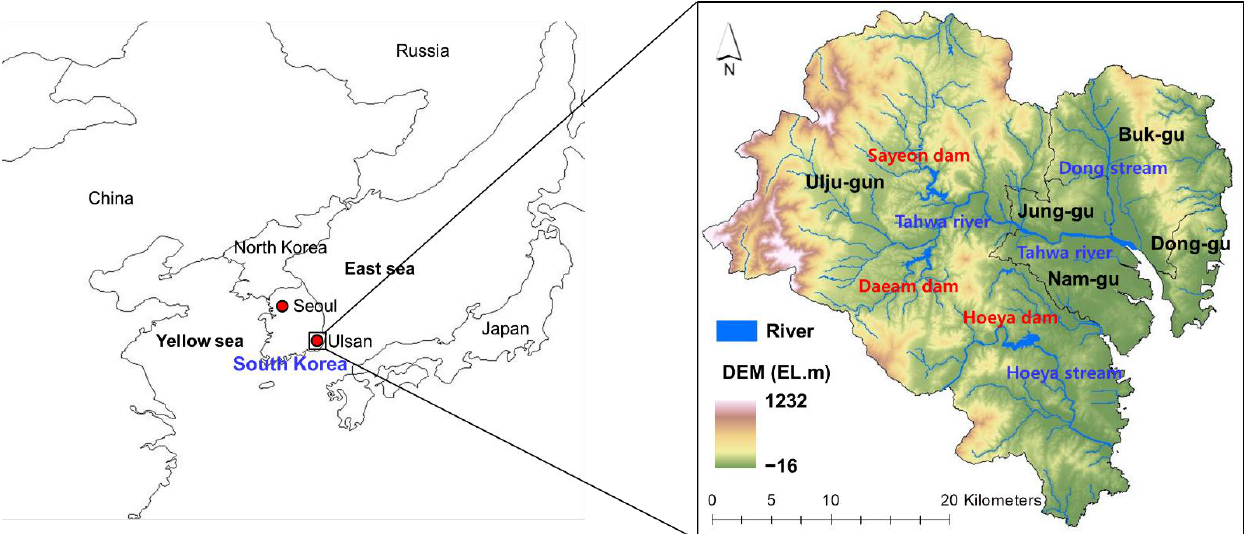
Figure 2. Target regions of Ulsan City in South Korea.